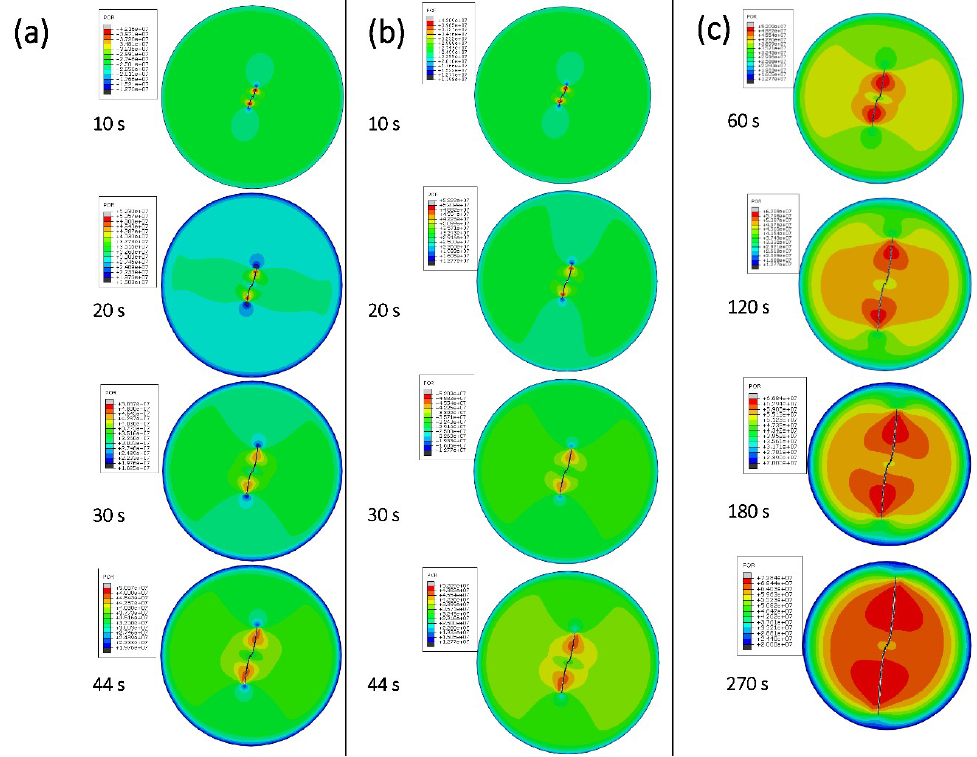
Figure 7. The distribution of the fracture morphology evolution. ( a ) Pure liquid CO 2 (0.04 mPa · s, 0–44 s); ( b ) Thickened liquid CO 2 (1.3 mPa · s, 0–44 s); ( c ) Thickened liquid CO 2 (1.3 mPa · s,